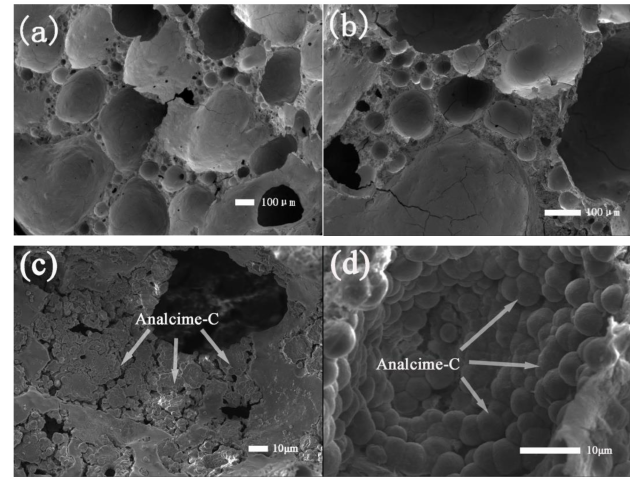
Figure 6. SEM images of ( a , b ) FAA1.0, and ( c , d ) AF1-2.